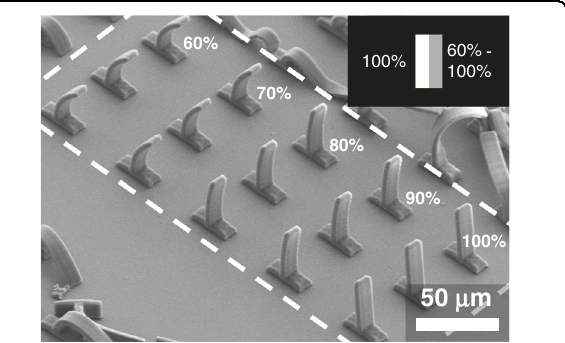
Fig. 7 Tuning structure characteristics using grayscale projection. Grayscale pattern projection demonstrating tunable material properties in printing of standing pillars. Percentages indicate grayscale level of the pattern shown in the inset. Print speed